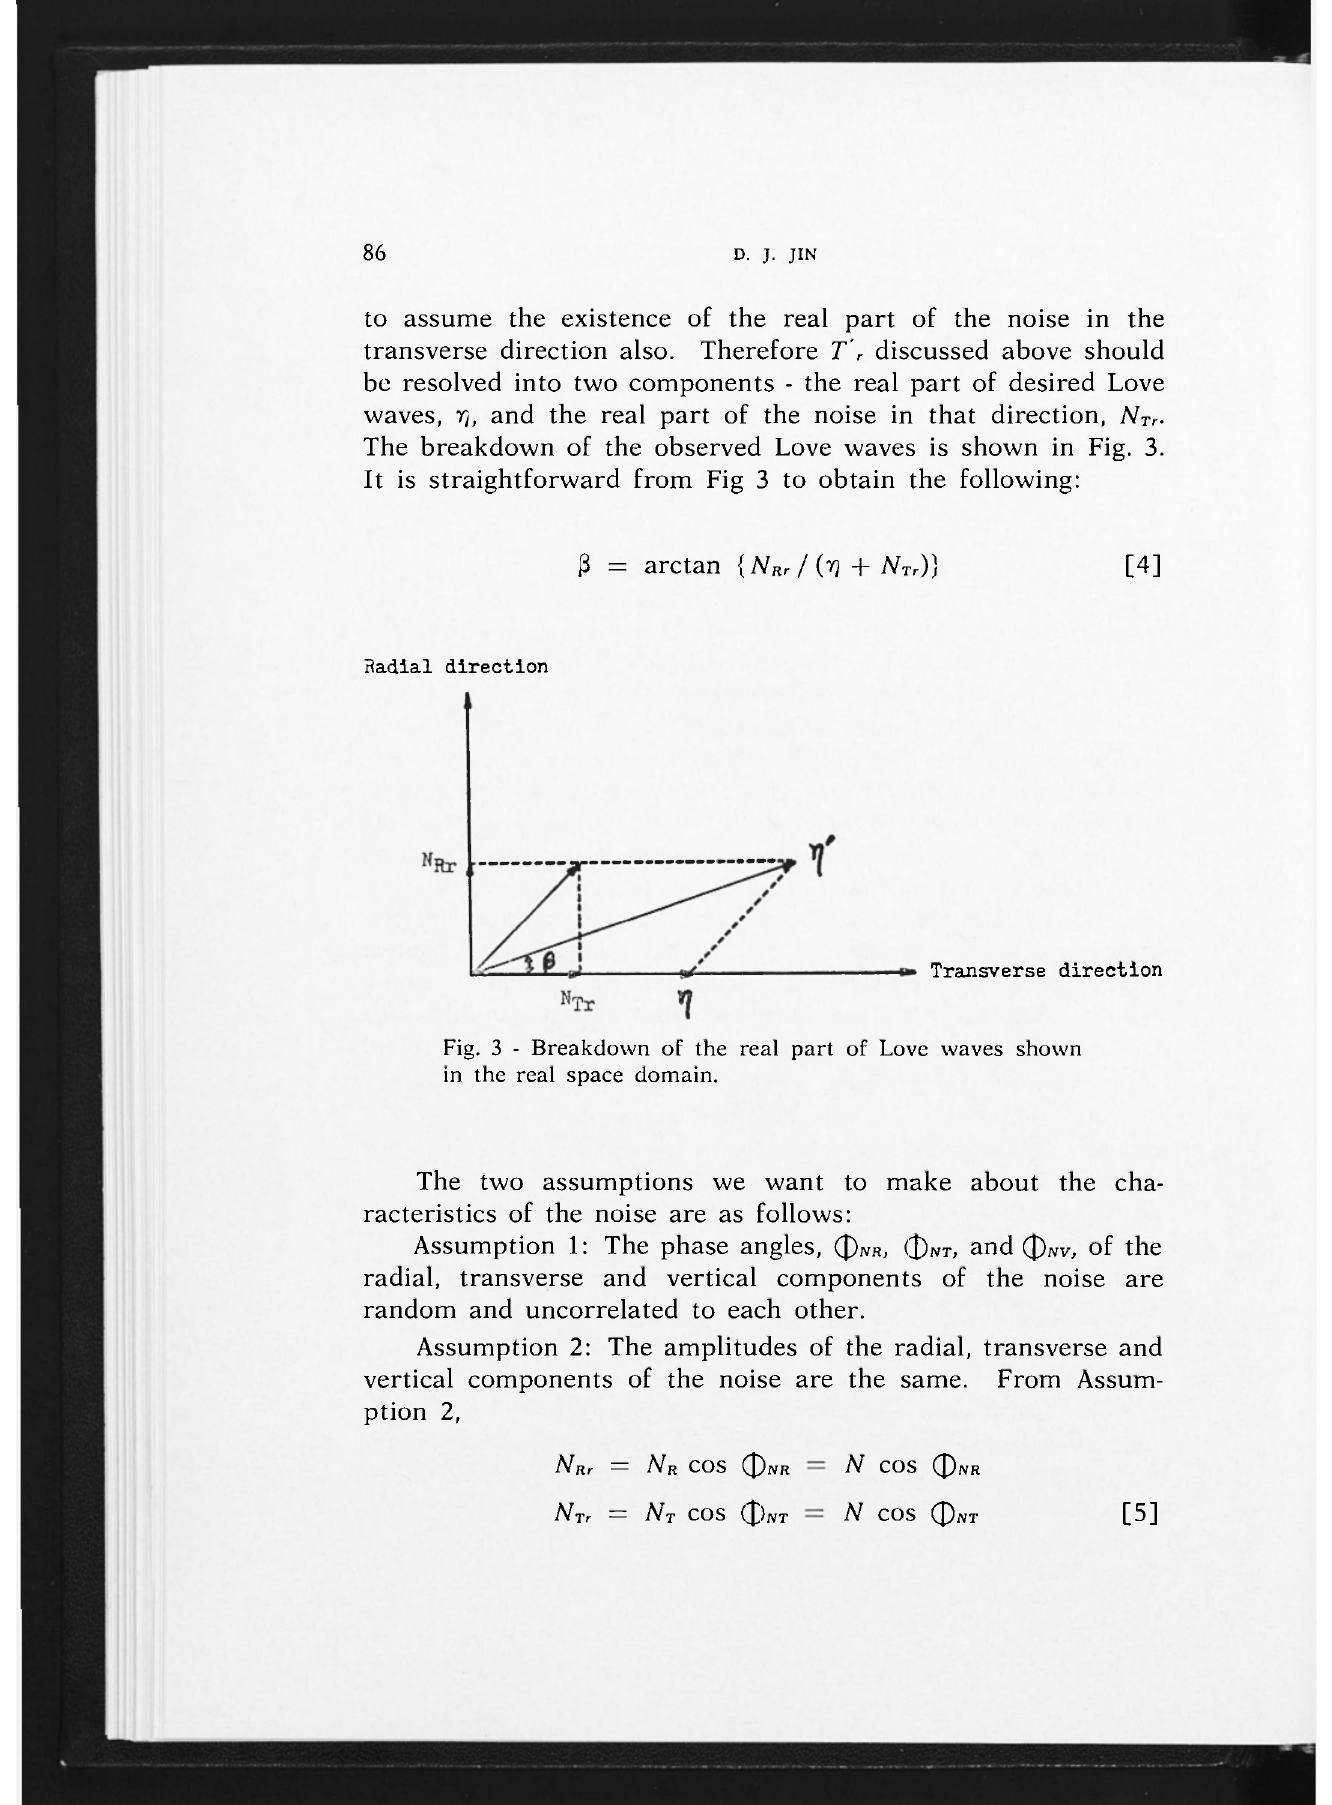
Fig. 3 - Breakdown of the real part of Love waves shown in the real space